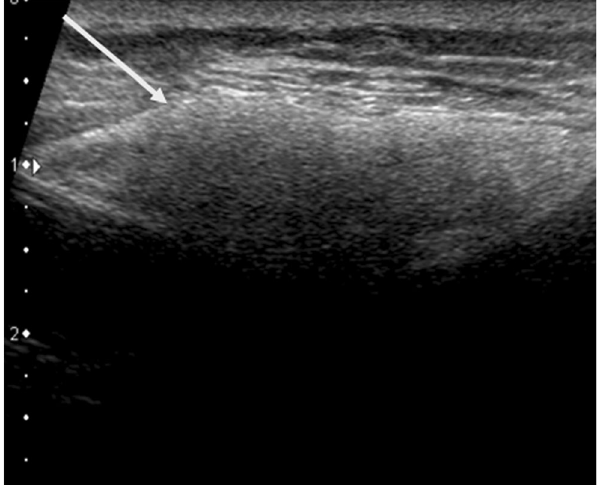
Fig. 11 Siliconoma. Periprosthetic silicone ( arrow showing a hyperechoic mass with attenuation of the ultrasound beam)